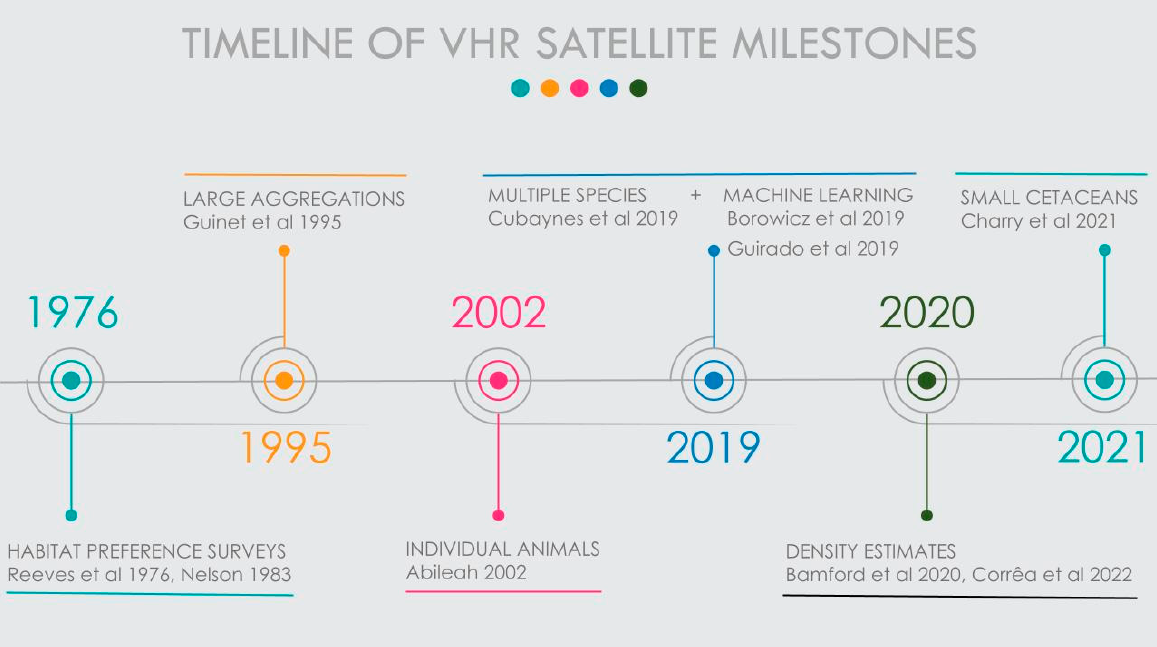
Figure 3. The timeline of advancements in wildlife research using very high-resolution (VHR) satellite imagery to understand habitat, distribution, and density with particular emphasis on developments relevant to the detection of marine mammals.